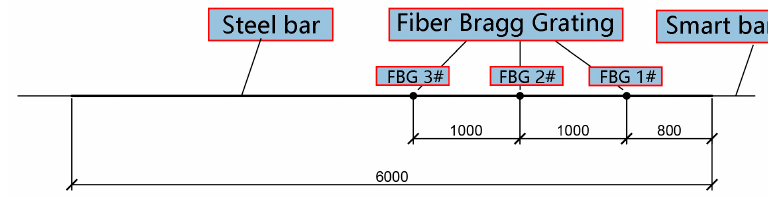
Figure 3. Photo of the prestressed smart composite cable (partial).